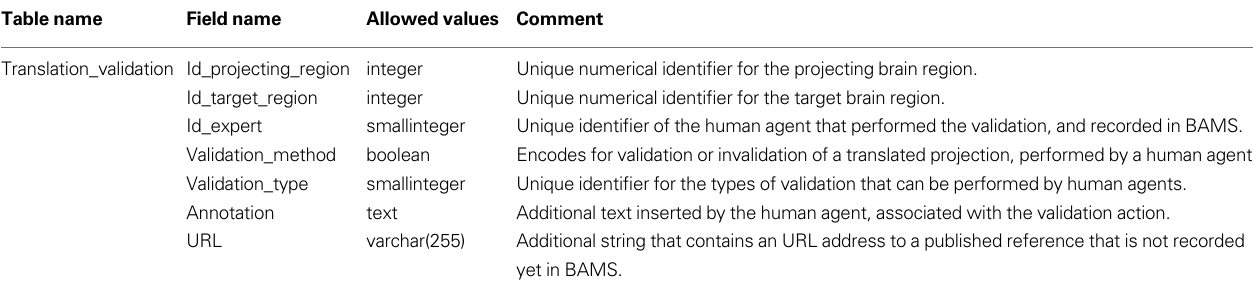
Table 3 | Details of the Translation_validation table, implemented in BAMS as part of the validation